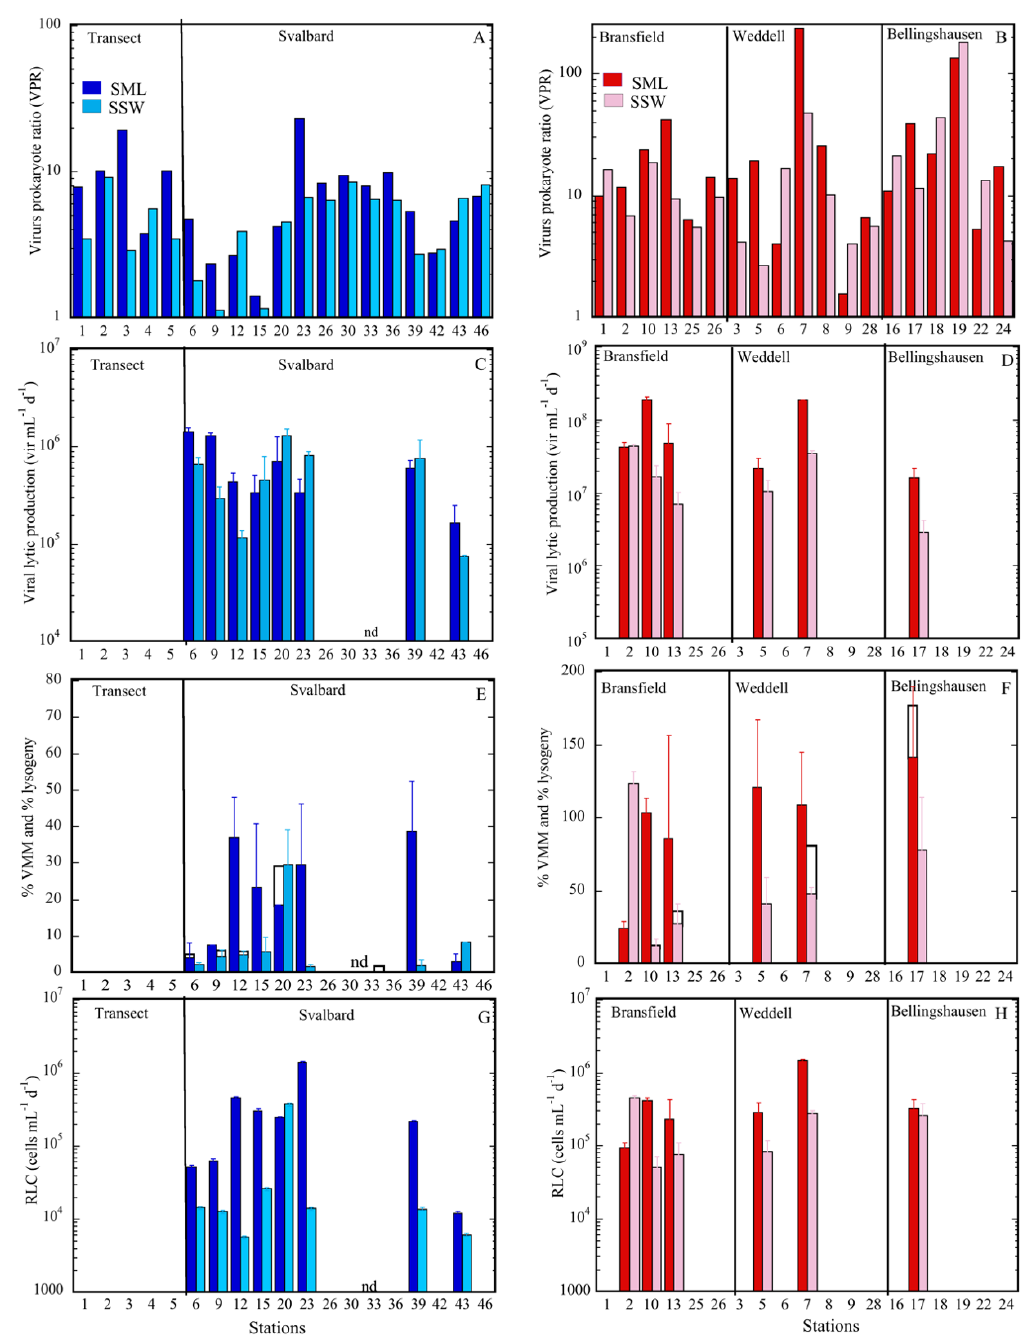
Figure 3. Viral parameters at the sampled stations of the Arctic and the Antarctic in the SML (dark-blue and red columns) and the SSW (light-blue and red columns) waters. VPR ( A , B ); VPL ( C , D ); lytic infection (%VMM, full columns), and %Lysogeny (empty columns) ( E , F ); and RLC ( G , H ). Error bars in each column indicate the maximum and minimum values of duplicates measured during the incubations, except for %Lysogeny (averages of total viral production—average VPL; see Material and Methods); nd: non-detectable. For acronyms, see Figure 2.